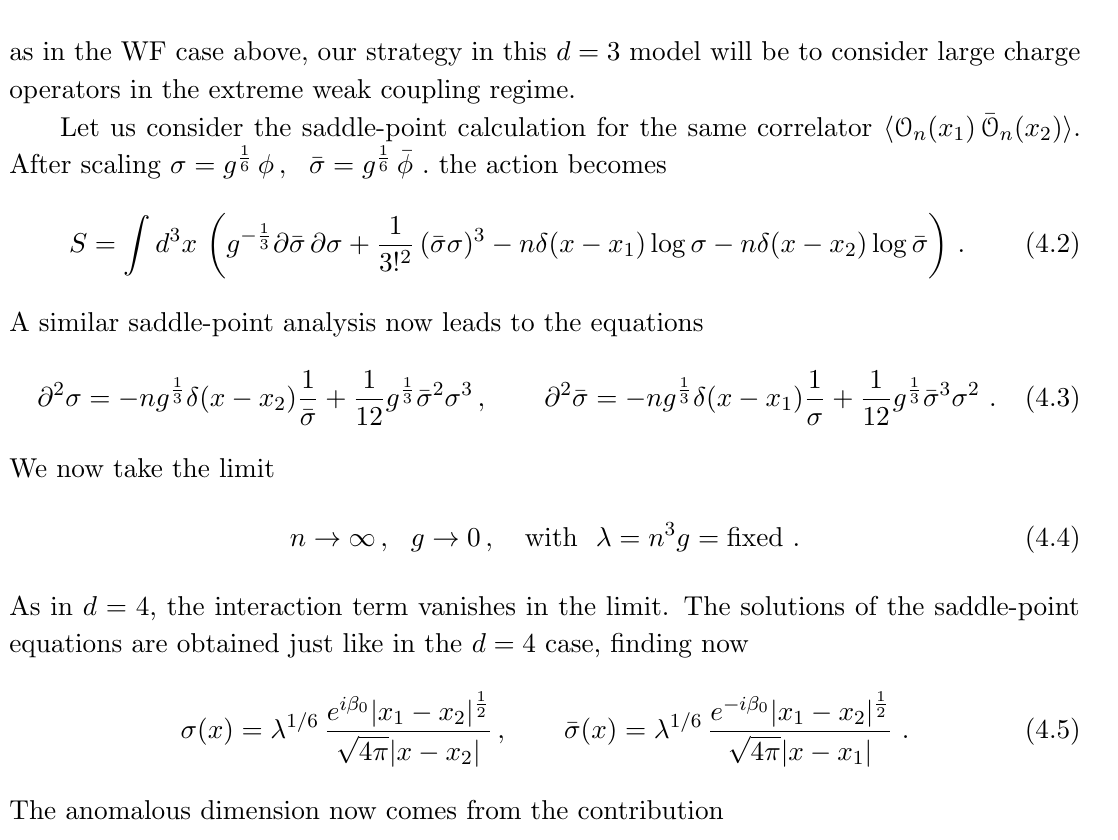
Figure 5 . Sleeping Kermit. The diagram represents the leading non-trivial contribution to the two-point correlation function of the d = 3 theory in the double-scaling